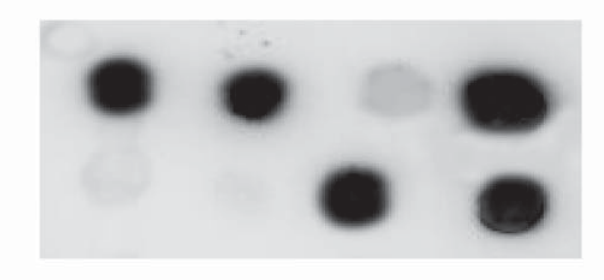
Fig. 2. Dot-blot analysis, from right to left and top to bottom of : reference strains SAS56, SAS405 and Tuni- sian isolates Bc 1.98, Bc2.98, Bc 6.98, Bc 24.00, Bc 13.99, Bc 15.99. Hybridisation was carried out using a 32 P la- belled